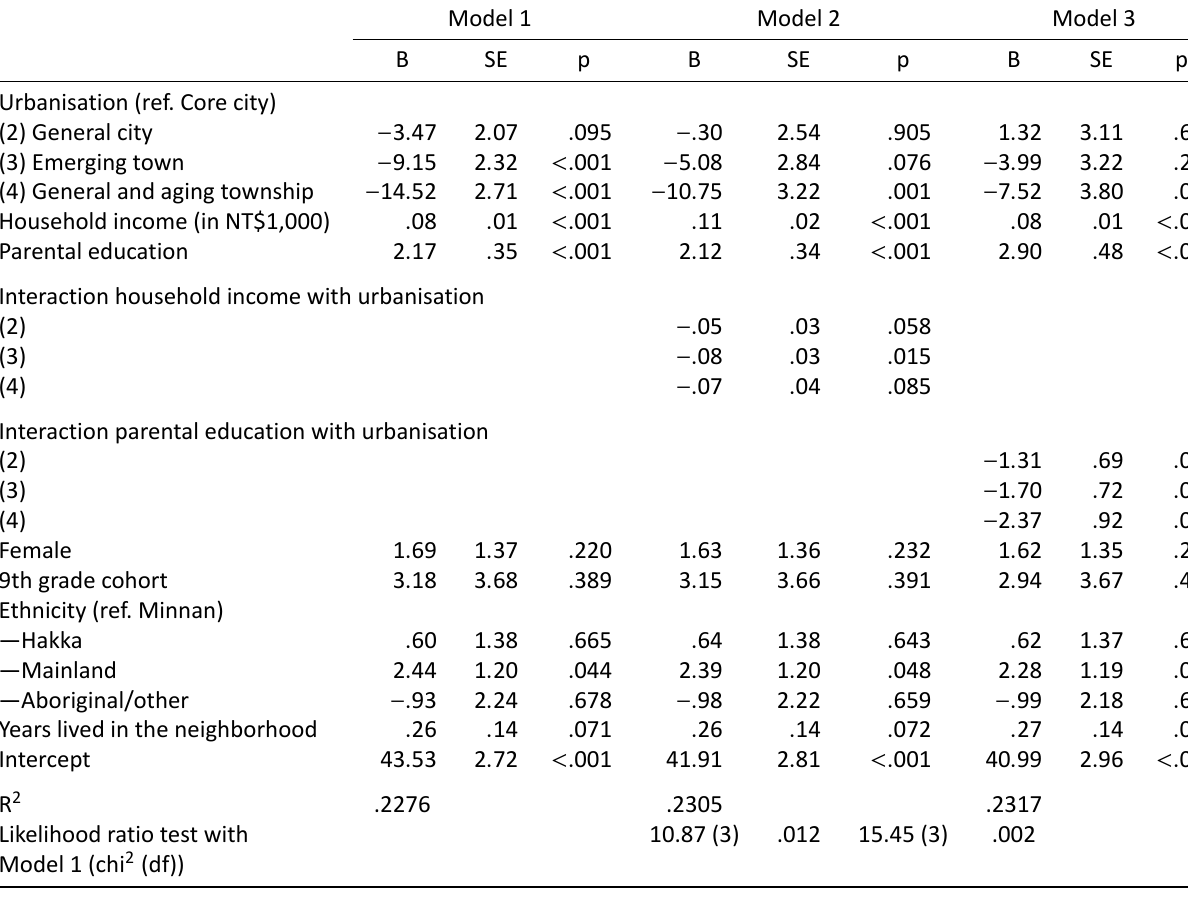
Table 4. Regression results for school income level (N =